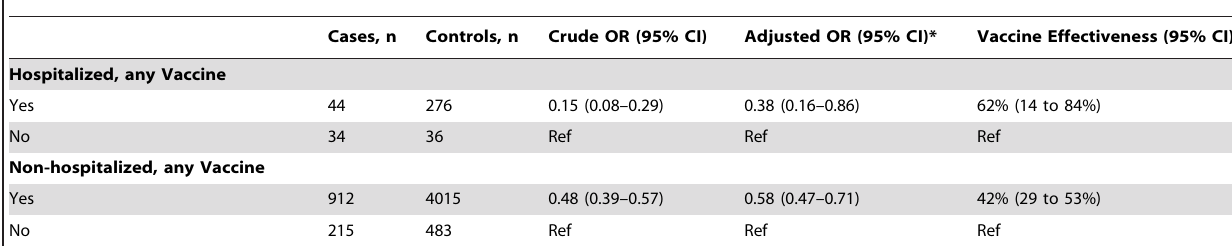
Table 6. Crude and Adjusted OR for Hospitalized and Non-hospitalized Cases and Controls.